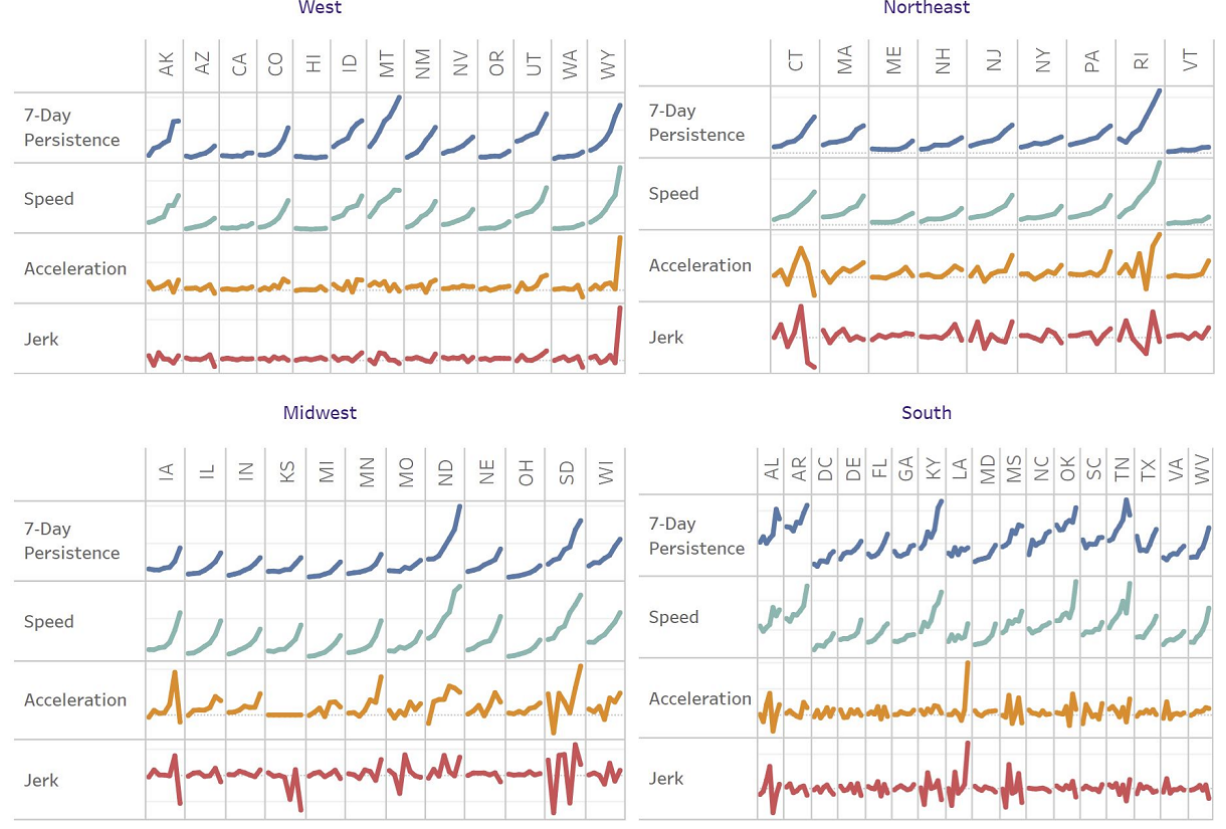
Figure 2. Weekly US state